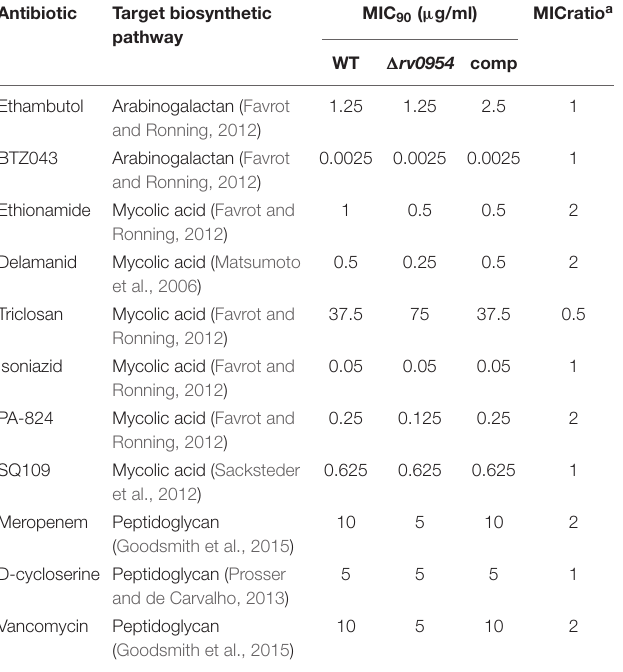
TABLE 2 | Drug susceptibility of H37Rv WT, (cid:49) rv0954 , and complemented strains. Antibiotic Target biosynthetic pathway